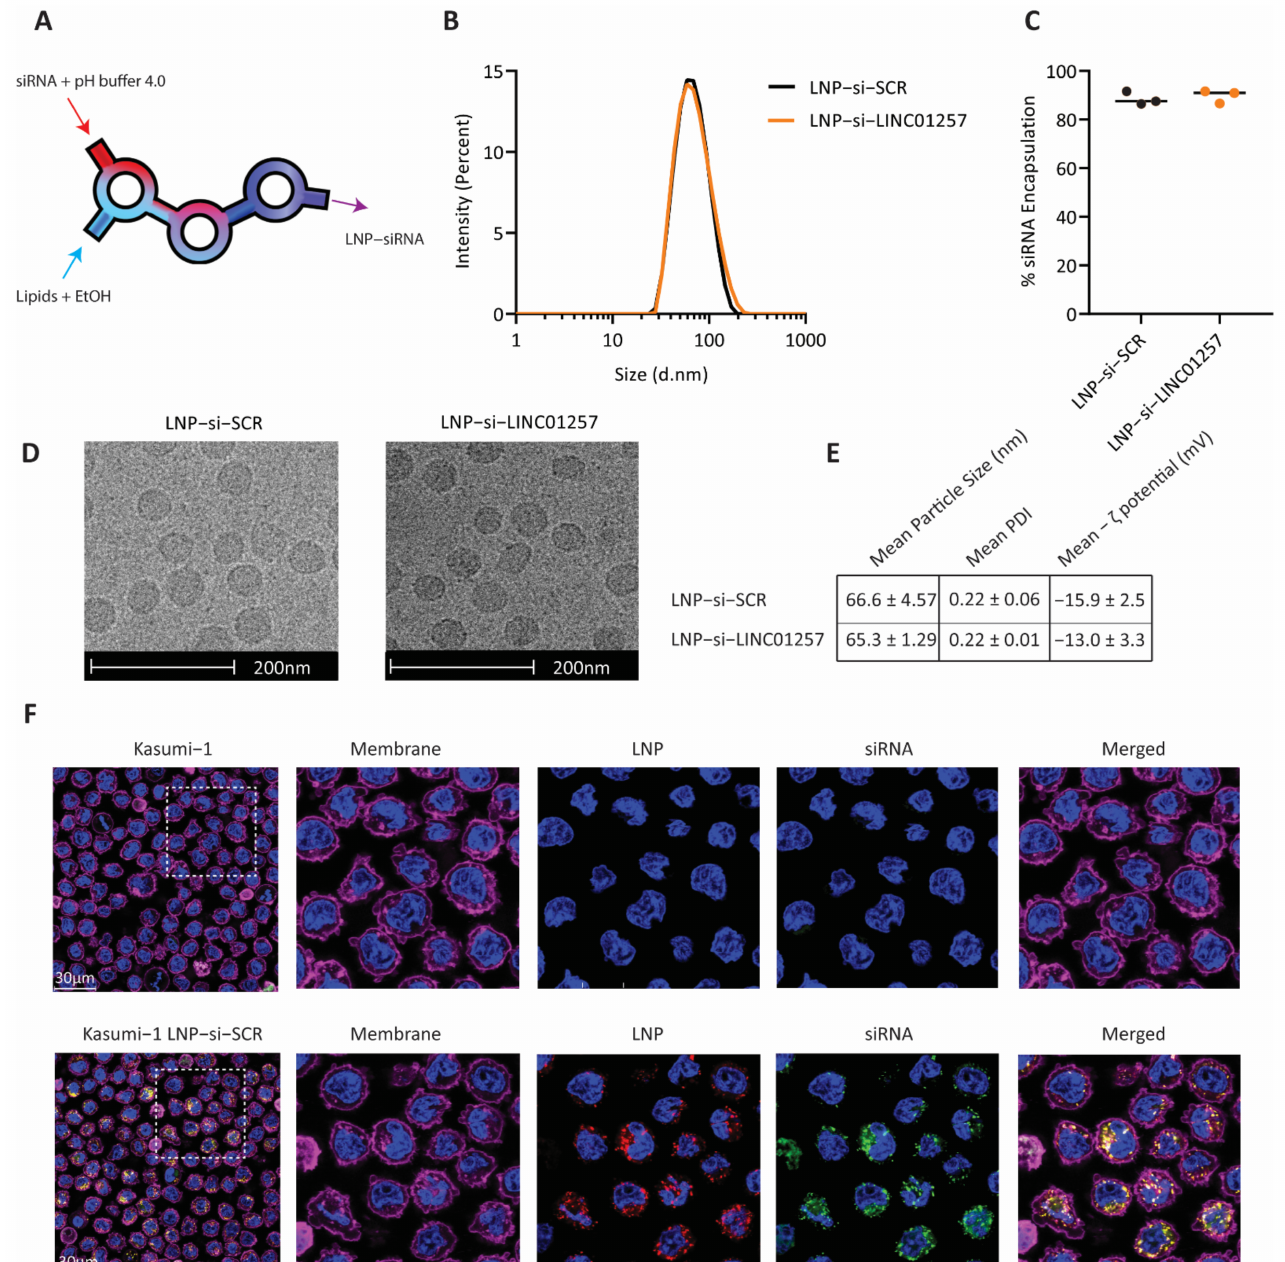
Figure 4. The NxGen non-turbulent microfluidics system generates stable LNP-siRNA particles. ( A ) Schematic of the NxGen non-turbulent microfluidics system. ( B ) Size analysis of LNP-si-SCR compared with LNP-si-LINC01257. ( C ) Average percentage of siRNA encapsulated within LNP of LNP-si-SCR compared with LNP-si-LNC01257 as determined by Ribogreen assay. ( D ) Cryogenic electron microscopy images of LNP-si-SCR and LNP-si-LINC01257. Scale bar: 200 nm. ( E ) Mean particle size, PDI and ζ potential for LNP-si-SCR and LNP-si-LINC01257 (mean ± SEM). n = 6. ( F ) Confocal microscopy images of untreated Kasumi-1 cells compared to Kasumi-1 treated with Rhodamine-tagged LNP (red) containing FAM- tagged siRNA (green) for 3 h. Hoechst-stained nuclei (blue). CellMask ® Deep Red stained membrane (purple). Scale bar: 30 µ M. White box denotes enlarged